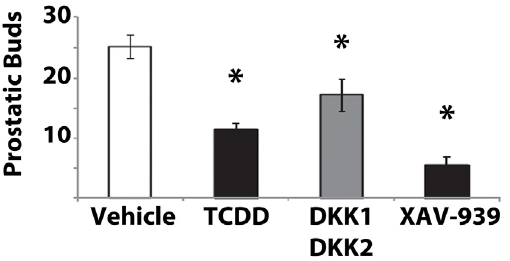
Figure 2. Prostatic bud development in vitro . UGSs were harvested from male C57BL/6J mouse embryos at E14.5 and grown in culture containing 5 α -dihydrotestosterone (DHT) plus vehicle, TCDD (1 nM), or canonical Wnt inhibitors dickkopf1 (DKK1) and DKK2 (500 ng/mL each) or XAV-939 (10 μ M) for four days. All prostatic buds were counted, and an asterisk indicates a significant difference compared to controls ( p ≤ 0.05).